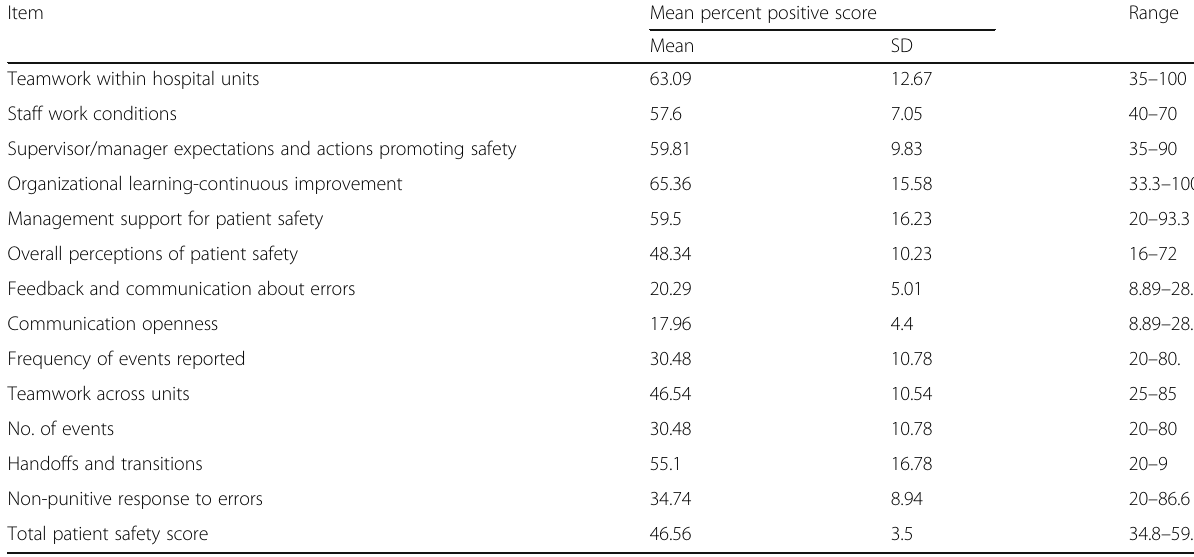
Table 2 Patient safety culture dimensions, Fayoum General Hospital, and other selected district hospitals, 2018 Item